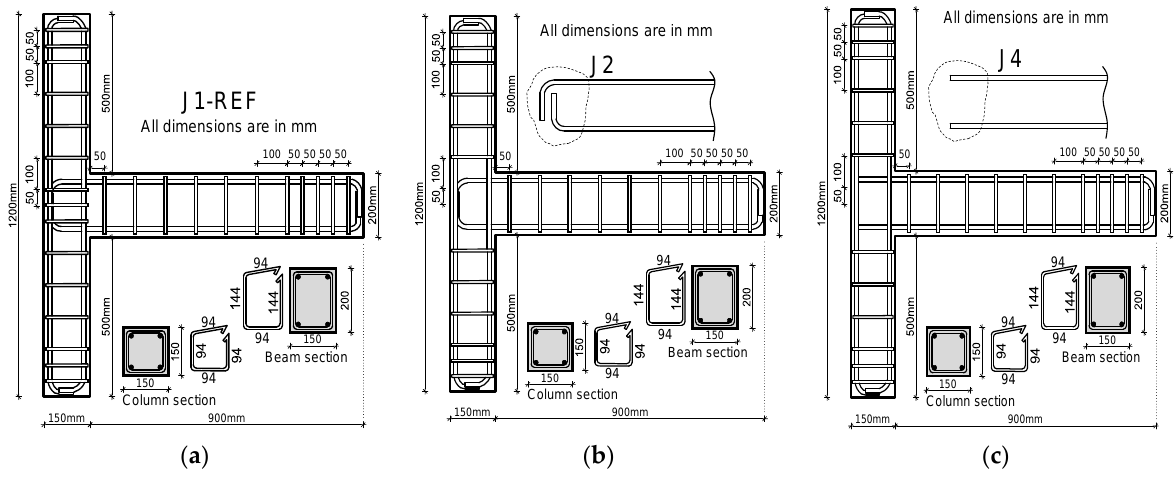
Figure 4. Specimen’s dimension and details. ( a ) Joint J1 details. ( b ) Joint J2 details. ( c ) Joint J4 details.